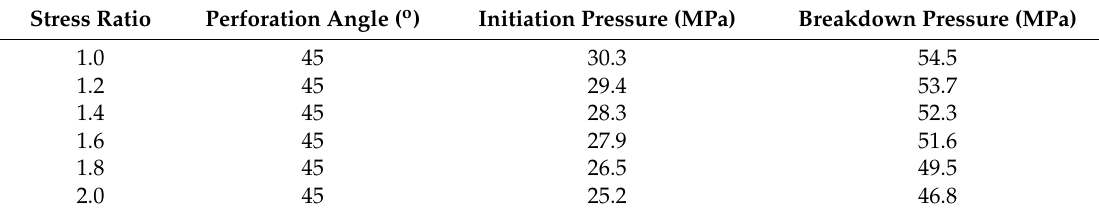
Table 3. Initiation pressure and breakdown pressure for different stress